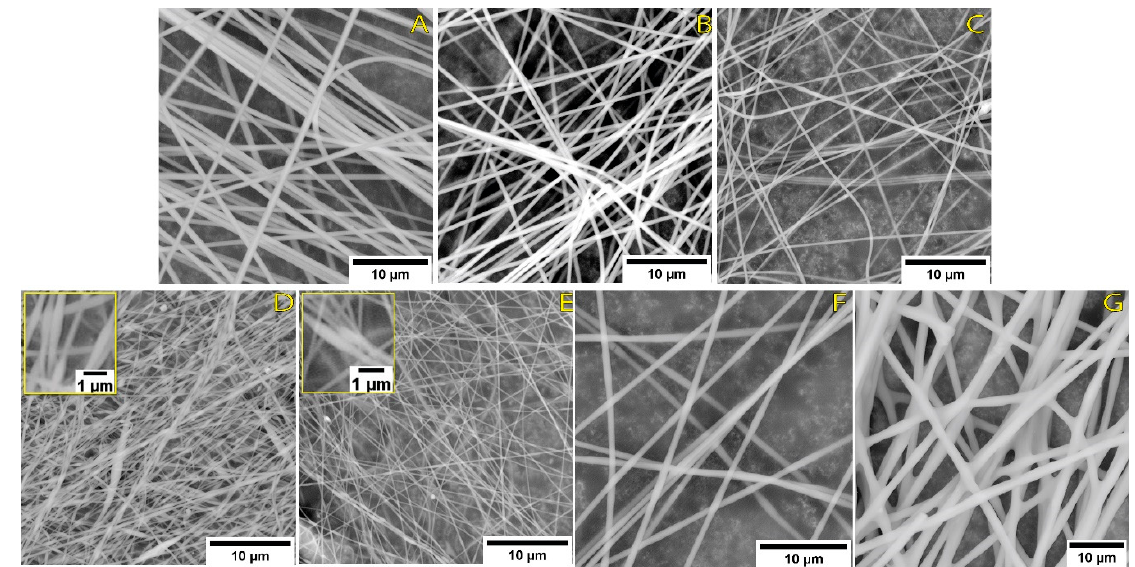
Figure 3. SEM images of electrospun PAN-MA/lignin nanofibers at a total polymer concentration of 10 wt % for ( A ) neat PAN-MA (control), ( B ) AL-1, ( C ) LSL-1, ( D ) AL-2, and ( E ) LSL-2; and at ( F ) 12 wt % AL-3, and ( G ) 20 wt % AL-4.